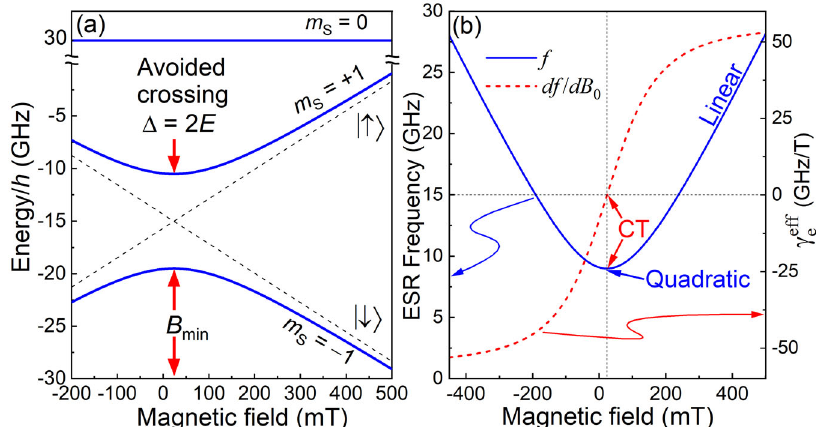
Fig. 1 Simulated HoW 10 Zeeman diagram and ESR frequency. a Zeeman levels (solid blue lines) according to the Hamiltonian of Eq. (1), with the parameters given in the main text. An avoided crossing (a clock transition) between the two lowest-lying states (labeled m S = ±1) is seen at B B : 6mT; the dashed lines denote the m = ±1 levels in the absence of an avoided crossing [i.e., E set to zero in Eq. (1)]. b ESR frequency, f S 0 z ¼ min ¼ 23 (solid blue curve), corresponding to the transition between the m S = ±1 states in ( a ), and the associated effective gyromagnetic ratio, γ eff red curve); the clock transition (CT) is indicated. Note that the ESR frequency couples linearly to B 0 far from the clock transition and quadratically at the clock transition, such that γ eff crosses through e